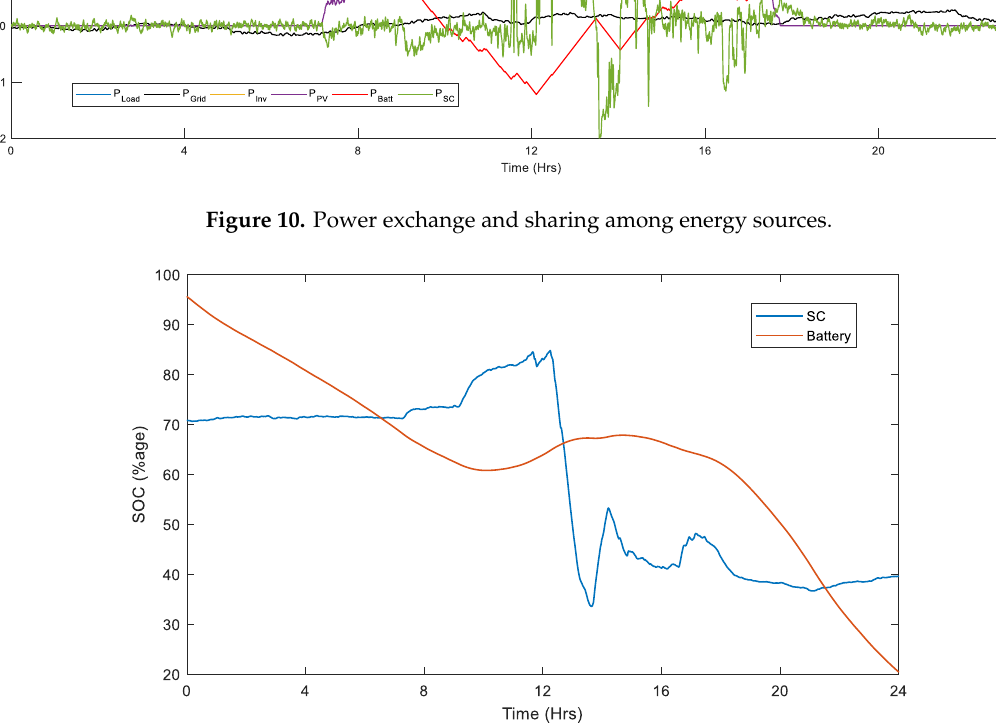
Figure 11. States of charge (SoCs) of the ultra-capacitor (UC) and battery.